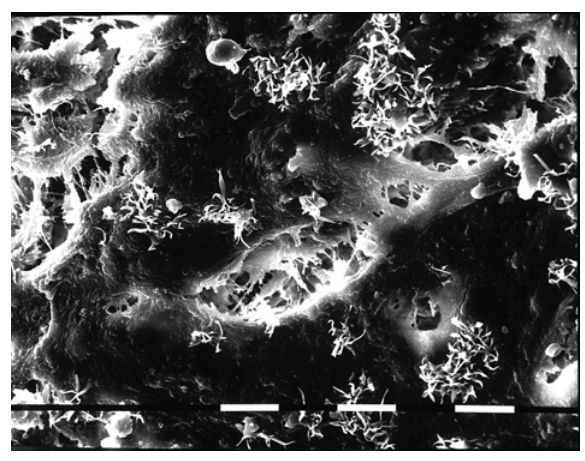
FIGURE 6. SEM micrograph of peri-implant tissue around Zr-SLA implant 2 weeks after surgery. Newly formed bone with osteoblasts in bone lacunae and needle-like crystals arranged in bone-like nodules next to the removed implant surface. Bar = 10 µm.